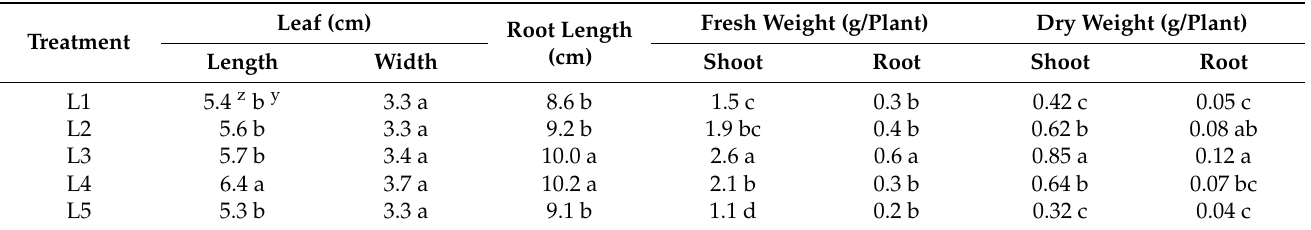
Table 4. Effect of light intensity on plant growth characteristics of apple seedlings at 30 days after treatment. L1, L2, L3, L4 and L5 indicate light intensity (Table 3).